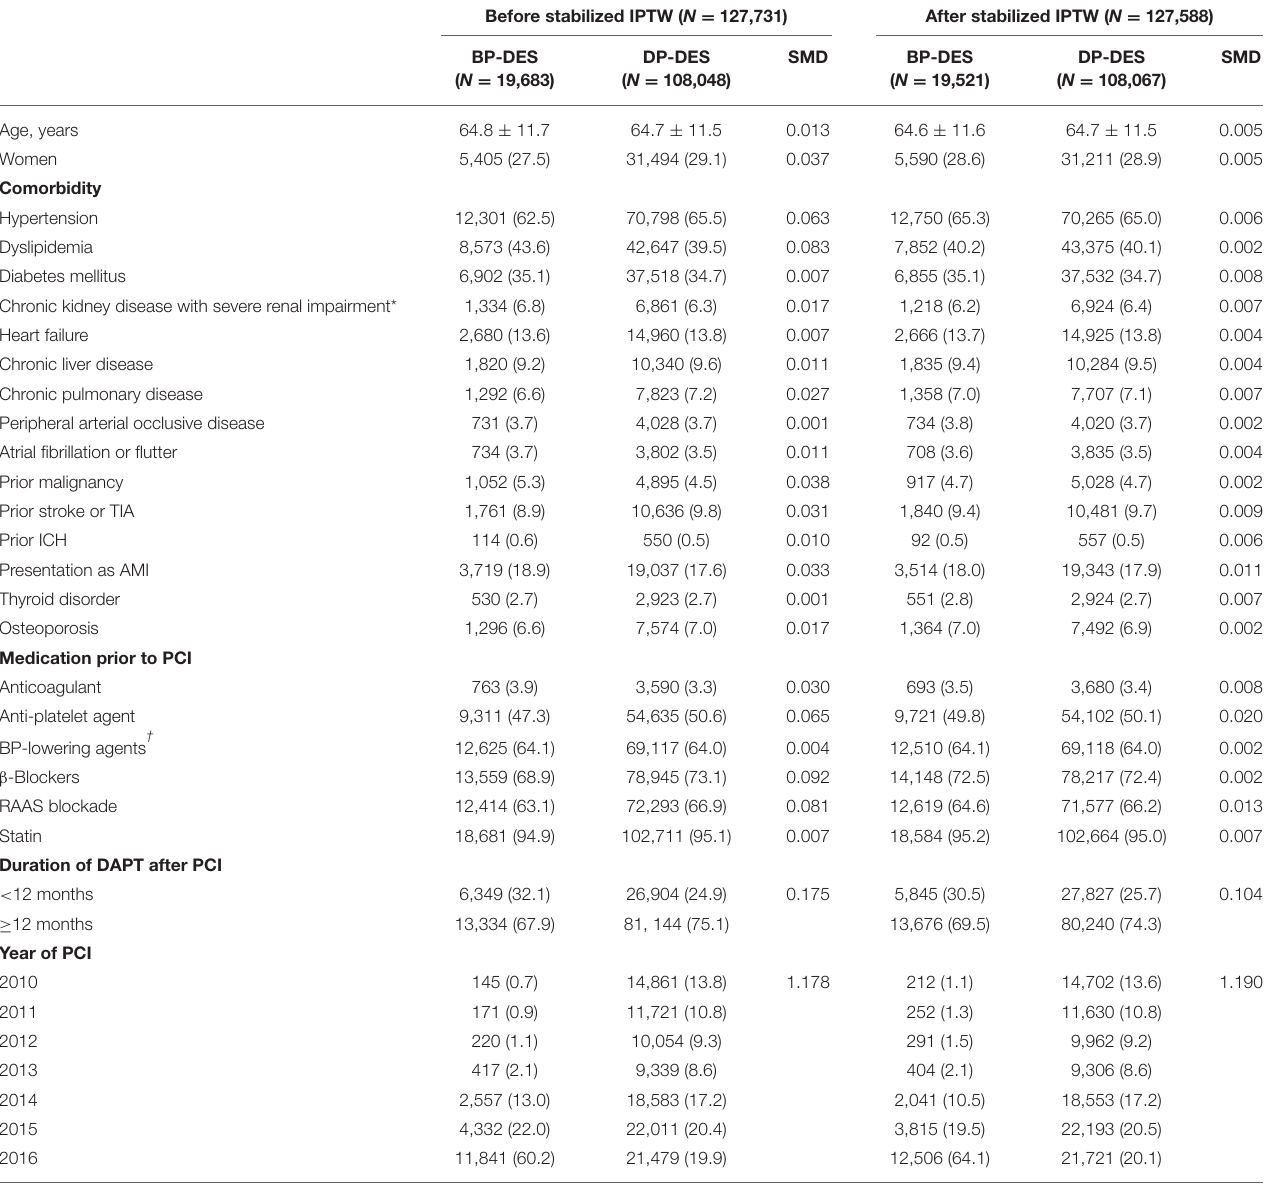
TABLE 1 | Baseline characteristics and medications at discharge after index